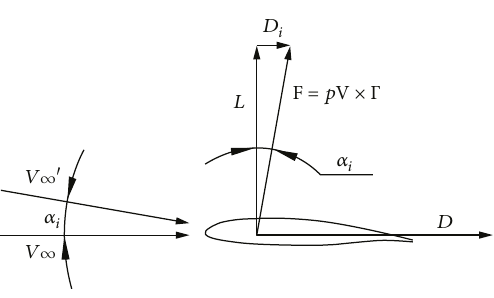
Figure 4: Schematic of the generation of the induced